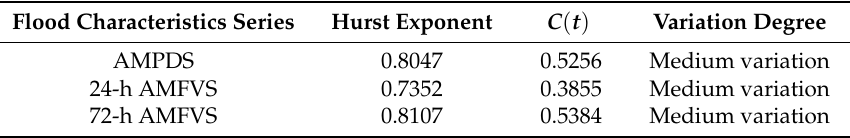
Table 3. Calculation results of the Hurst exponent for each flood characteristic series.